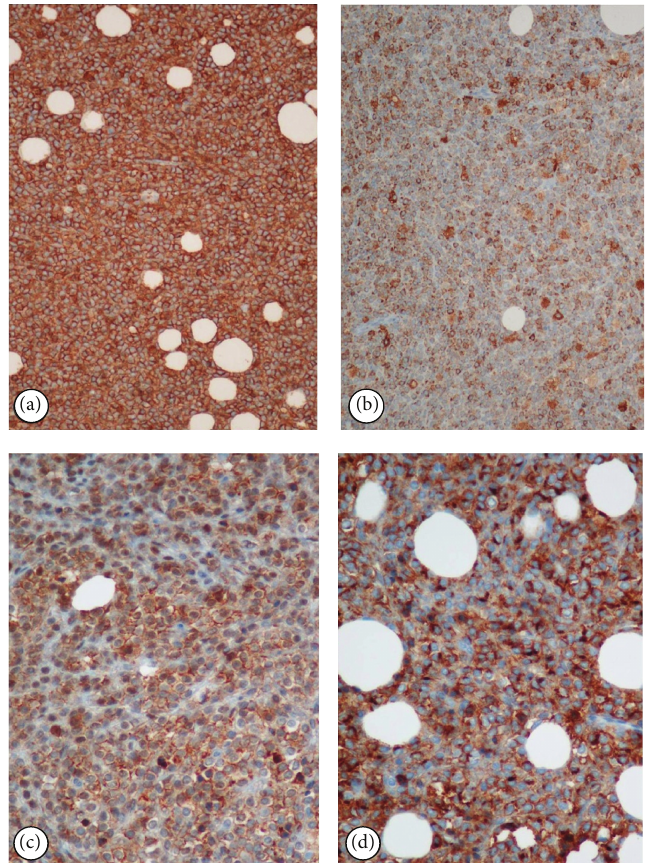
Figure 5: Immunohistochemical features of the infiltrated cells in the right femur expressed CD20 ((a) × 200), TRAP ((b) × 200), CD11c ((c) × 400), and annexin ((d) ×